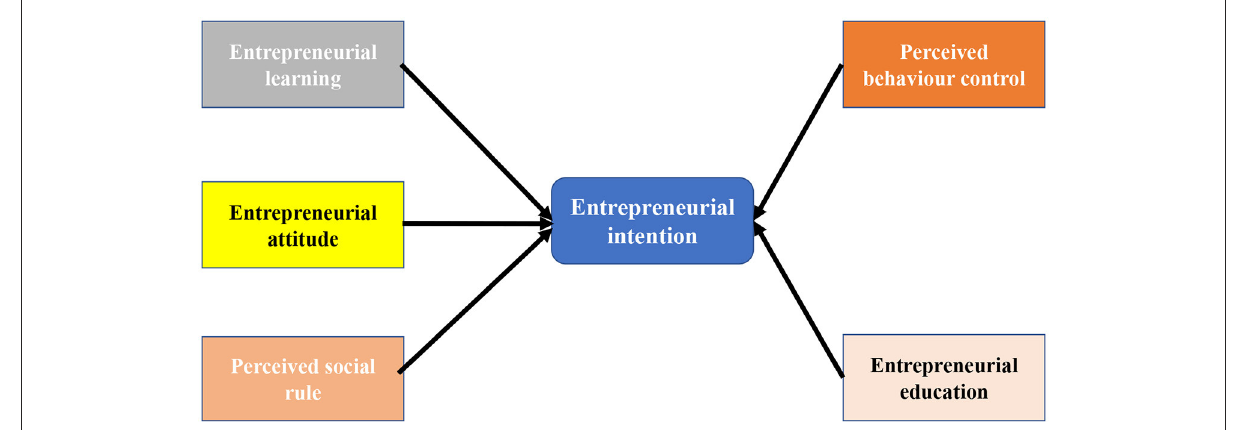
FIGURE1 A model for predicting the entrepreneurial intentions of management